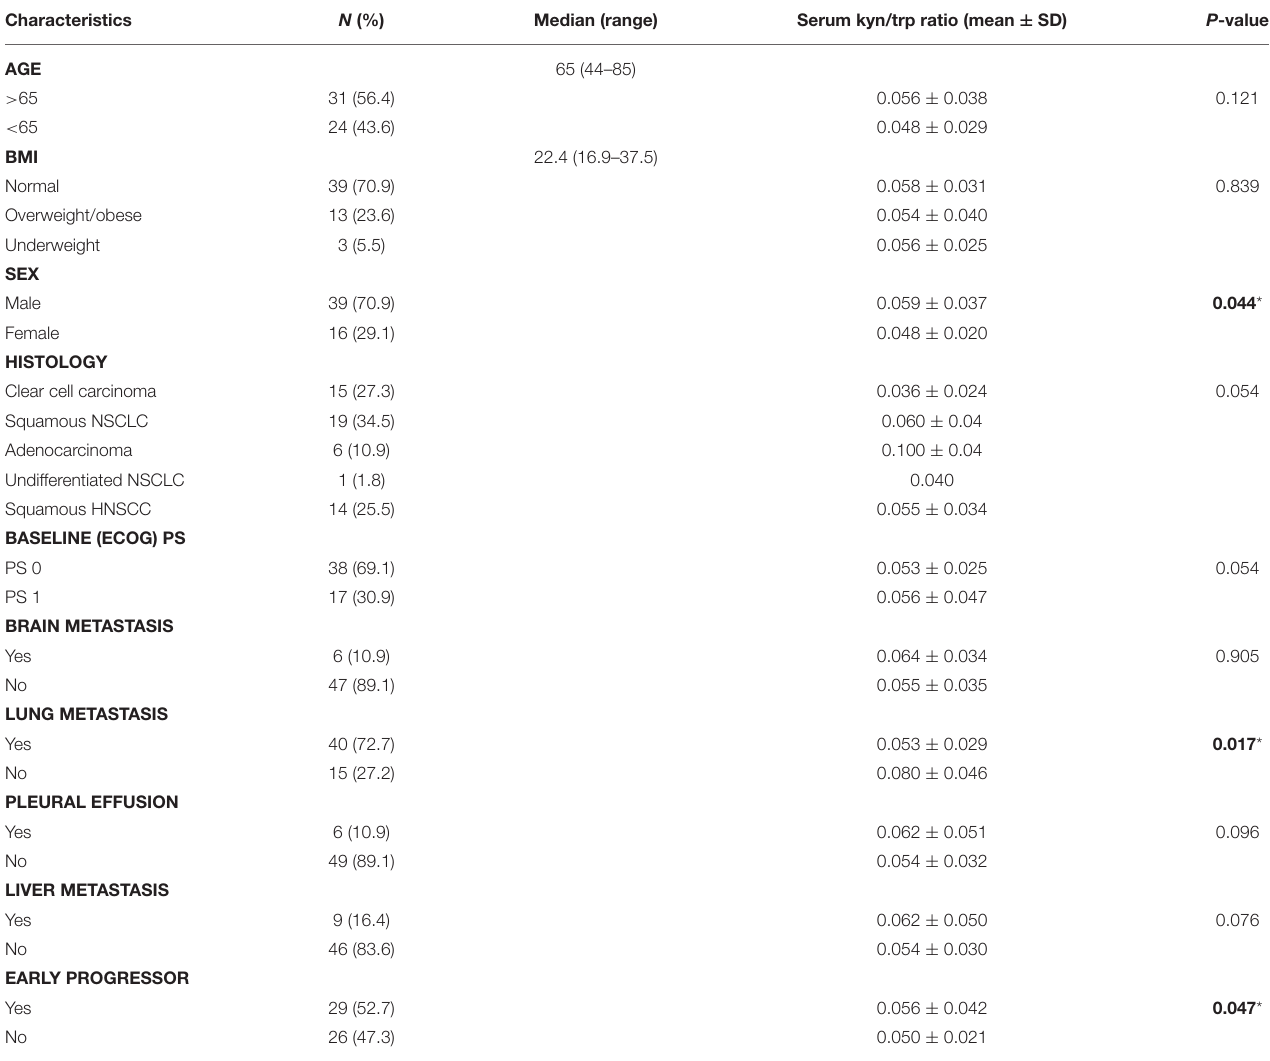
TABLE 1 | Association between baseline clinicopathological characteristics of the study population and kyn/trp ratio.